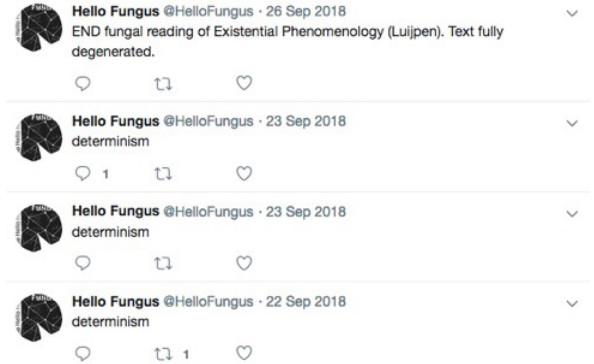
Figure 7 | @HelloFungus final tweets of Lujipen reading,